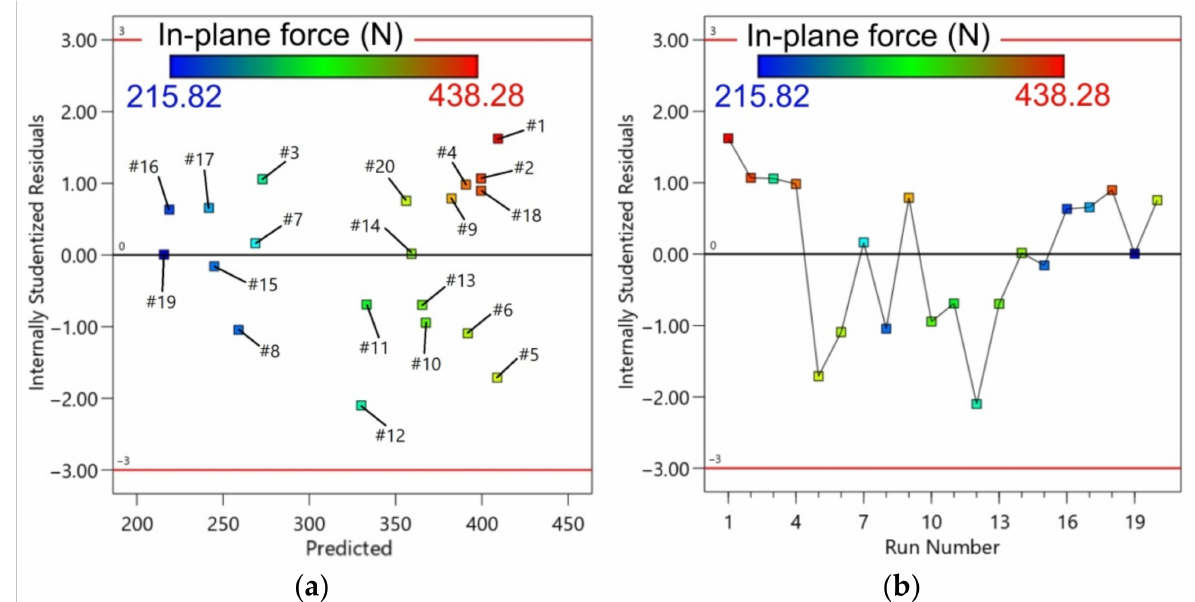
Figure 11. Residuals with reference to: ( a ) predicted; and ( b ) run number for in-plane